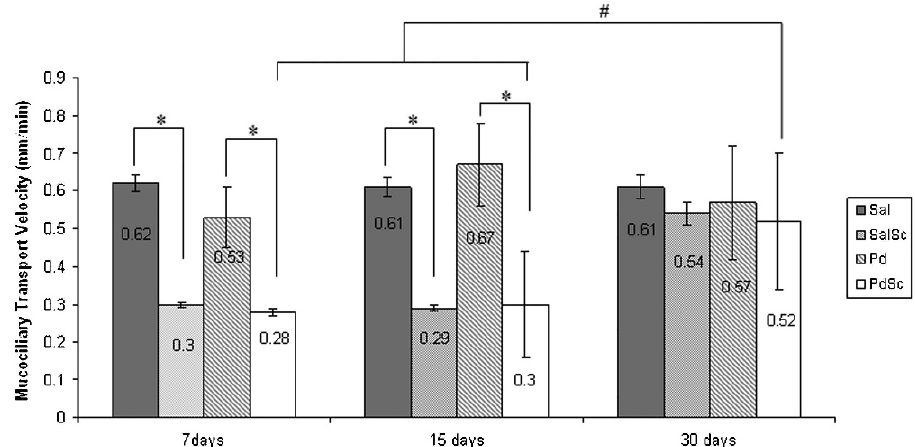
Figure 2 - The mucociliary transport velocity (mean ¡ standard deviation) of animals undergoing or not undergoing bronchial section and anastomosis and treated with prednisone or saline solution for 7, 15, or 30 days. Animals assessed 7 and 15 days after the surgical procedure had a lower mucociliary transport velocity compared with the non-surgical groups (* p , 0.001). Groups assessed after 30 days did not present a significant difference in this variable. Groups undergoing surgery had a lower mucociliary transport velocity 7 and 15 days after the surgery compared to animals assessed after 30 days ( # p ,